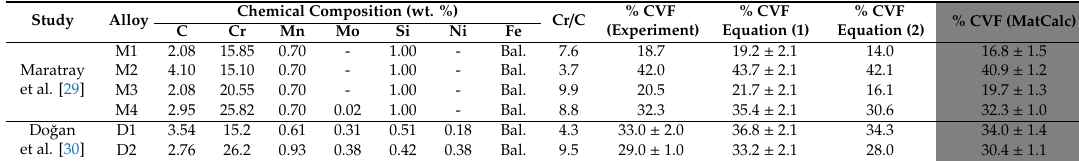
Table 4. The % CVF of certain alloys experimentally determined by [29,30], the numerical estimations and the corresponding % CVF computed using MatCalc (in grey).